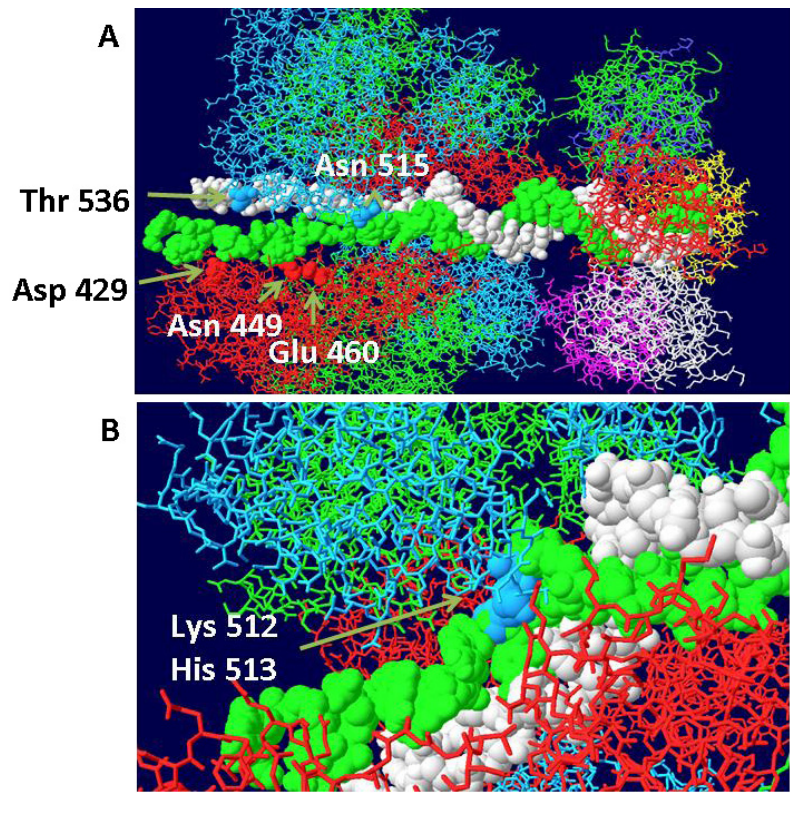
Figure 5. Threading of DNA through the large tier subdomains. Double stranded DNA is shown going through the central channel of the small tier subdomains and separate in the large tiers. One strand (white) continues within the central channel of the large tier subdomains. The other (green) is threaded within a hydrophilic channel that lies between monomer helicase domains (red and blue subunits). As shown in ( A ), it passes close to several residues that have been shown to be important in origin unwinding. ( B ) Close-up of same structure showing the location of residues 512 and 513 in the (cid:69) -hairpin of the blue